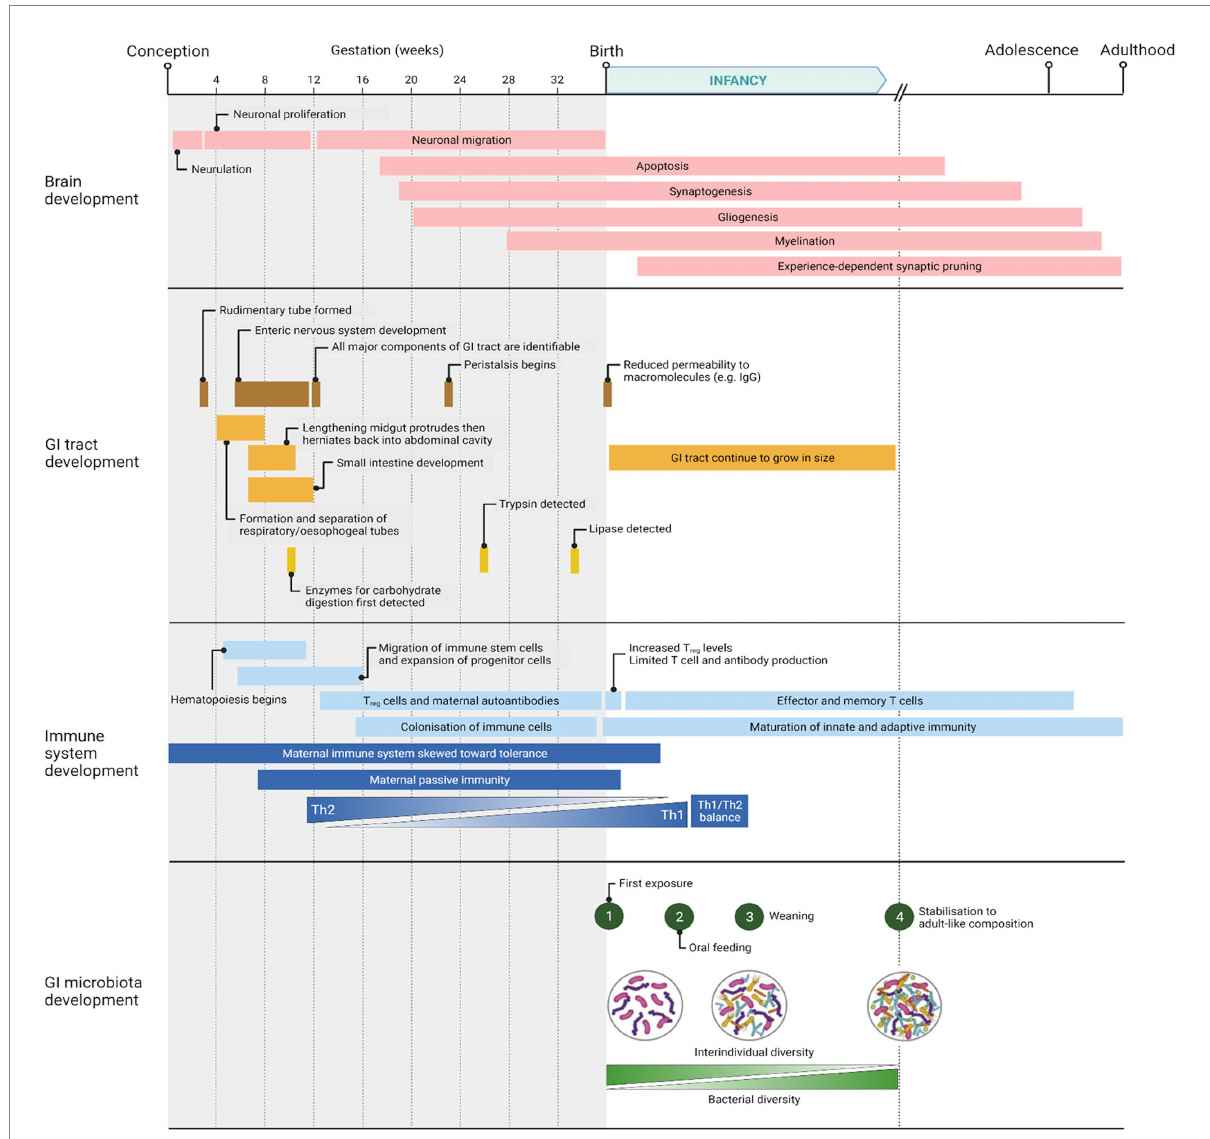
FIGURE 1 Timeline of major events occurring in brain, GI tract, immune system, and GI microbiota development from conception to adulthood. Created with